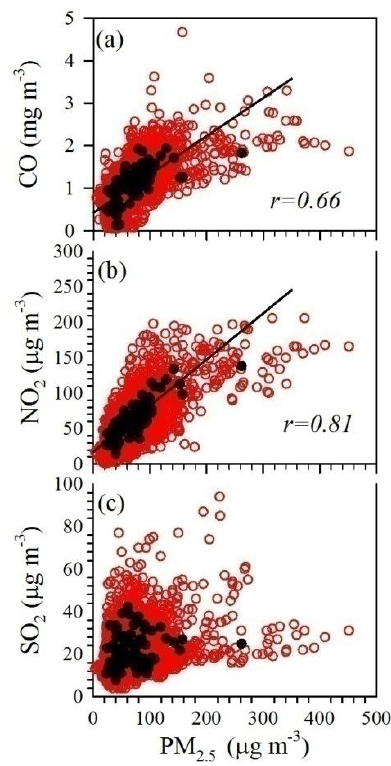
Figure 5. Linear relationships between the concentrations of PM 2.5 and CO ( a ), NO 2 ( b ), and SO 2 ( c ). The red circles and black dots are the hourly and daily concentrations, respectively and the correlation coefficients are calculated from daily concentrations.